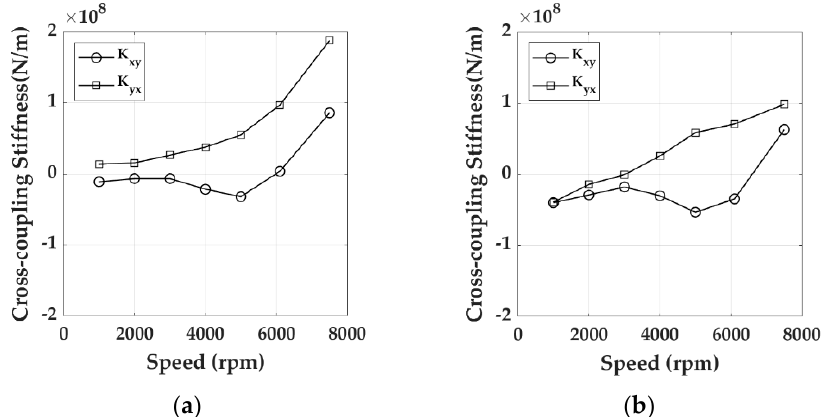
Figure 28. Direct Lube Rocker Pivot bearing synchronous cross-coupling stiffness: ( a ) 0.8 MPa, ( b ) 1.7 MPa.